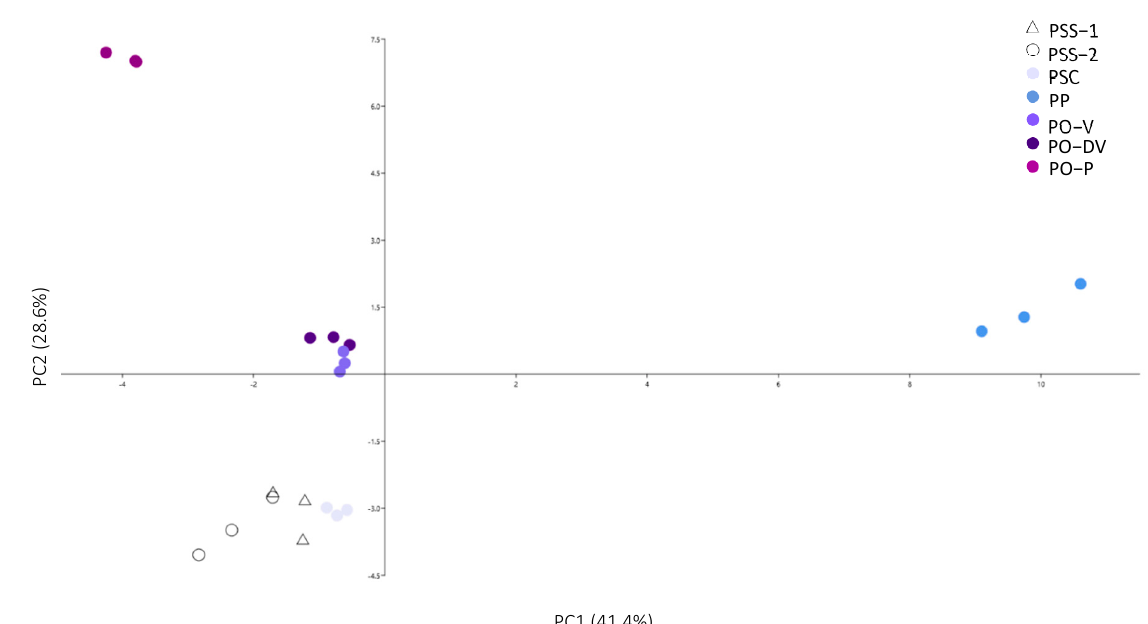
Figure 5. Principal component analysis of all phenolic compounds in Phyteuma . PSS-1, P.